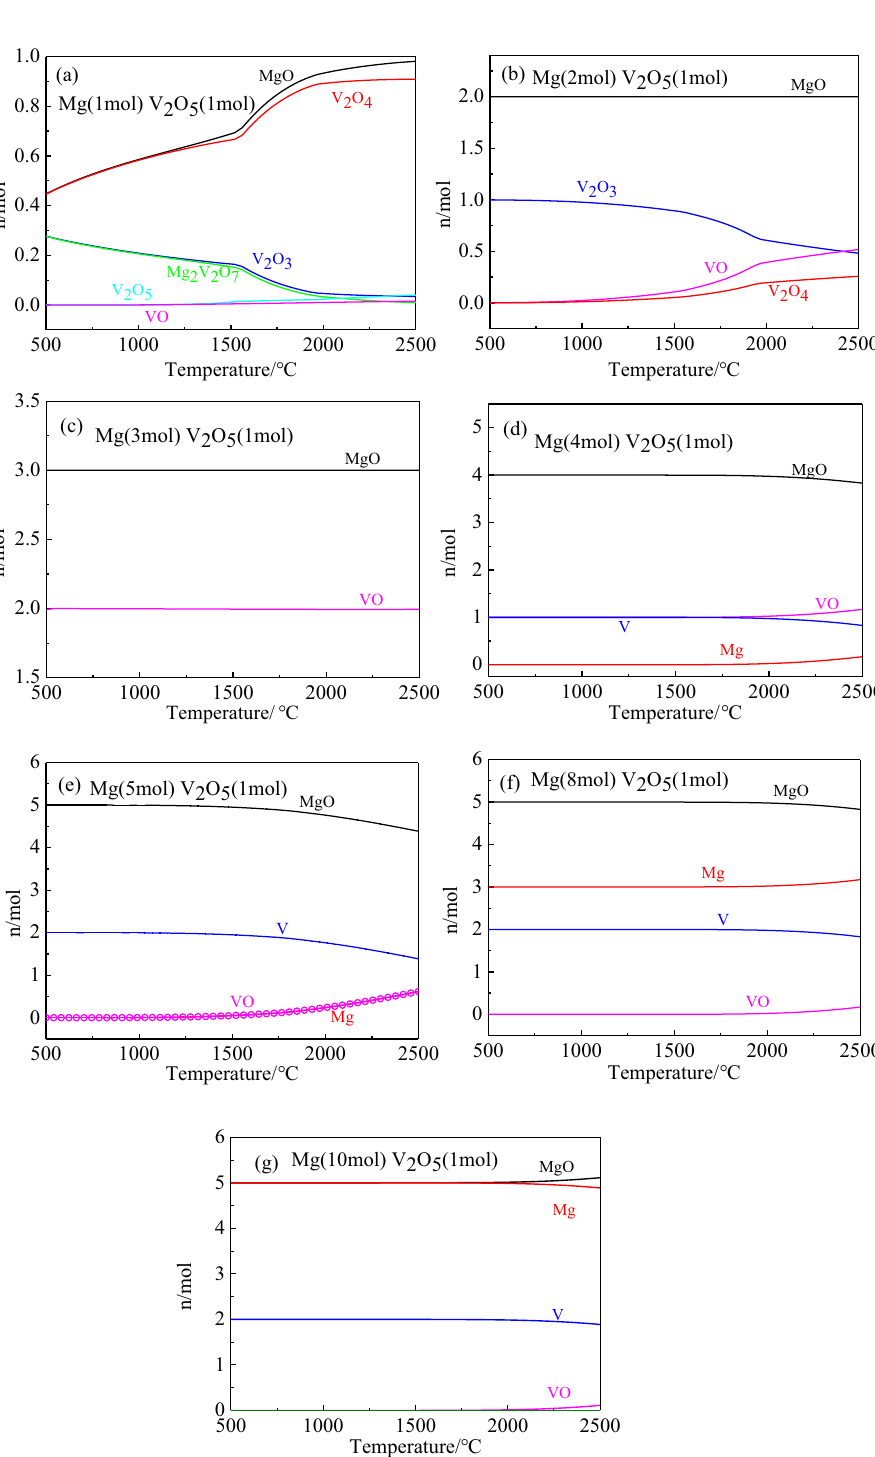
mass fraction of oxygen in the metal vanadium was about Table 2 shows the chemical composition analysis results of the products after pickling. As can be seen, 3#, and 4# ) , although the acid leaching product phase